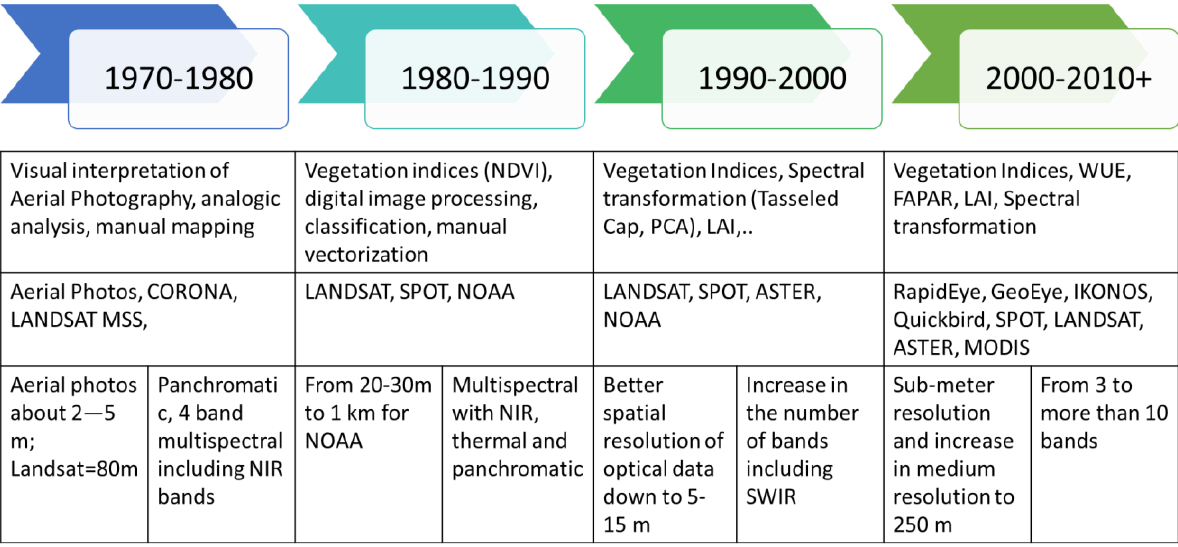
Figure 4. The evolution of remote sensing data and methods used in assessing land degradation in the Sahel. LAI (Leaf Area Index); NDVI (Normalized Difference Vegetation Index); PCA (Principal Component Analysis); WUE (Water Use